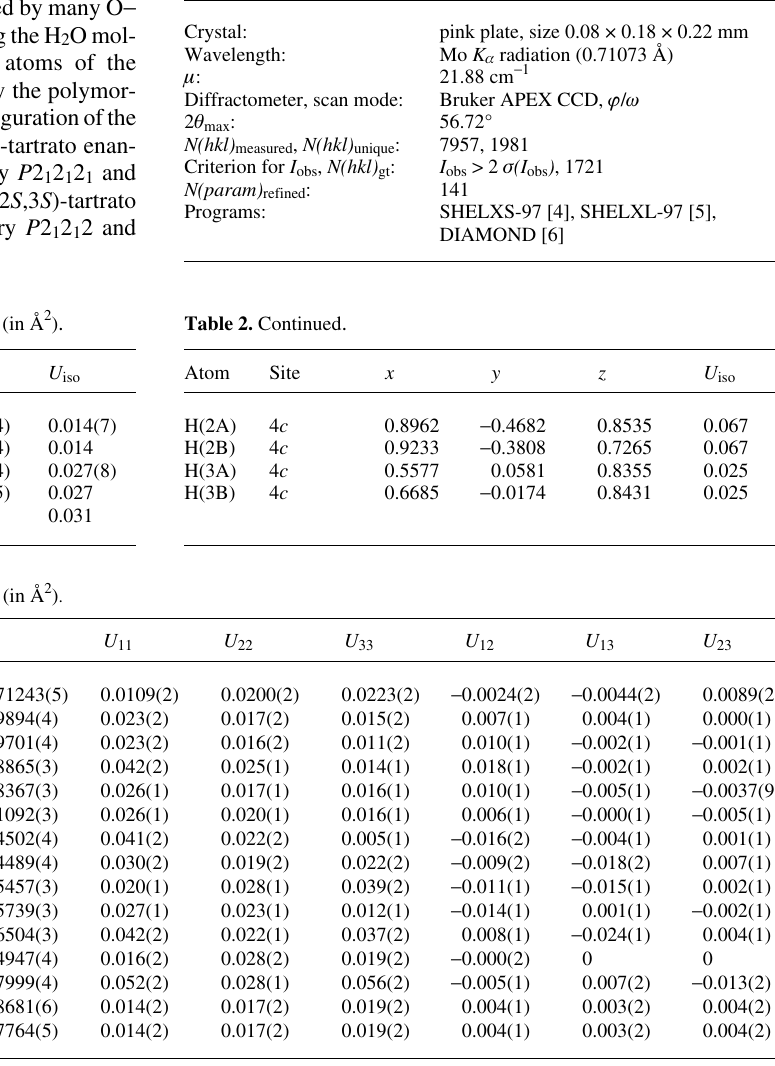
Table 1. Data collection and handling.